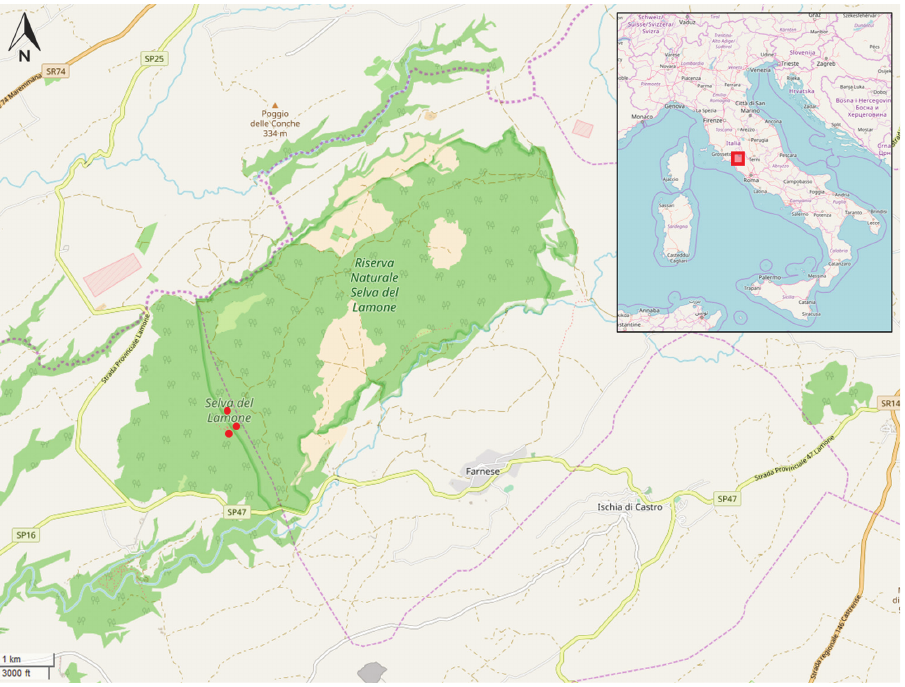
Figure 8. Distribution map of Ophioglossum azoricum in